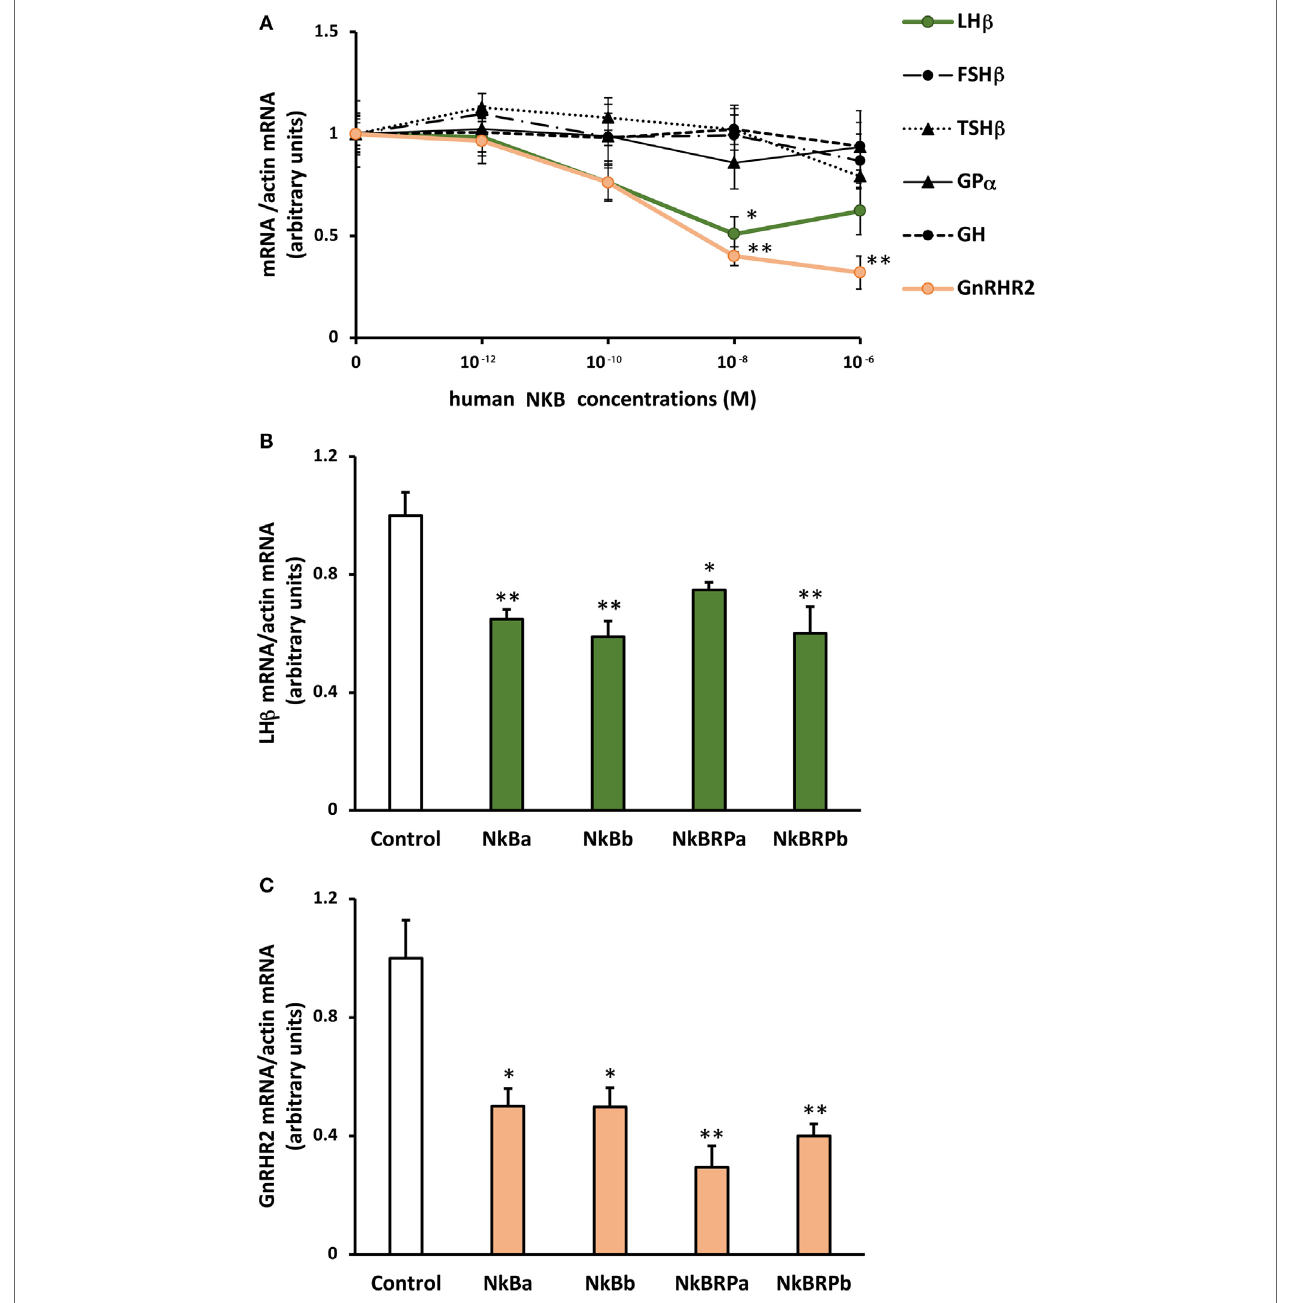
FigUre 5 | Effect of human (a) and eel (B) TAC3 peptides on pituitary hormone and gnrh receptor expression by eel pituitary cells. (a) Primary cultures of pituitary cells were treated with various concentrations (10 − 12 , 10 − 10 , 10 − 8 , and 10 − 6 M) of human neurokinin B (NKB) for 10 days. Pituitary hormones and receptor mRNA levels were quantified by qPCR. (B,c) Pituitary cells were treated with 10 − 7 M of eel TAC3 peptides, NKBa, NKBb, NKB-RPa, and NKB-RPb for 10 days. lh β (B) and gnrh-r2 (c) mRNA levels were quantified by qPCR. This figure displays the results of representative experiment. Data were normalized against β - actin. Each point represents mean ± SEM from five well replicates. * P < 0.05 and ** P < 0.01 versus controls, t -test or